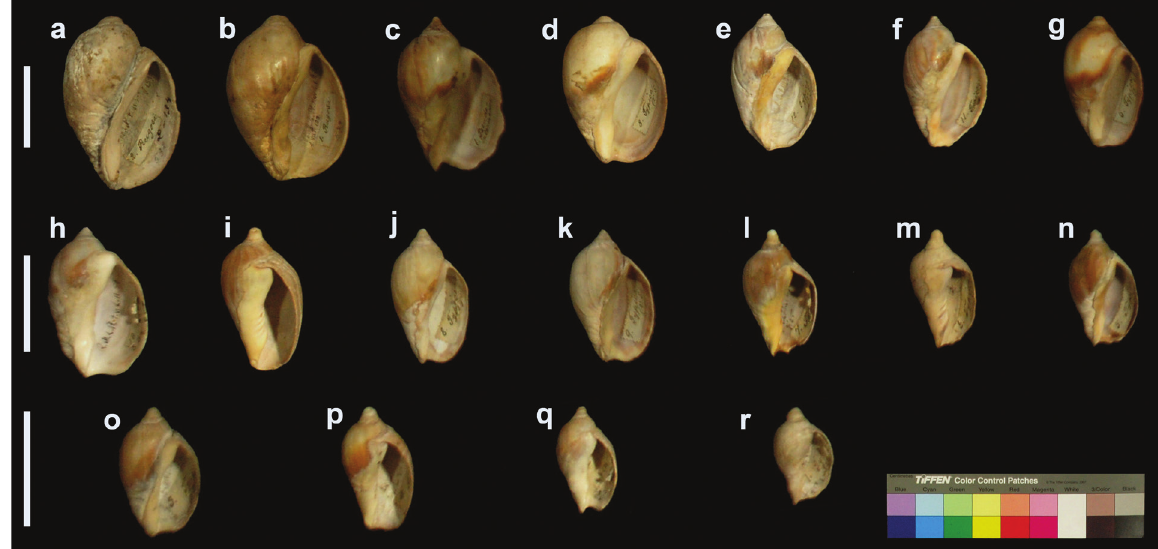
Figure 45. Voluta oviformis typica , specimens of figured by Lahille (1895).See references on Table 17. Scale bars: 5 cm.